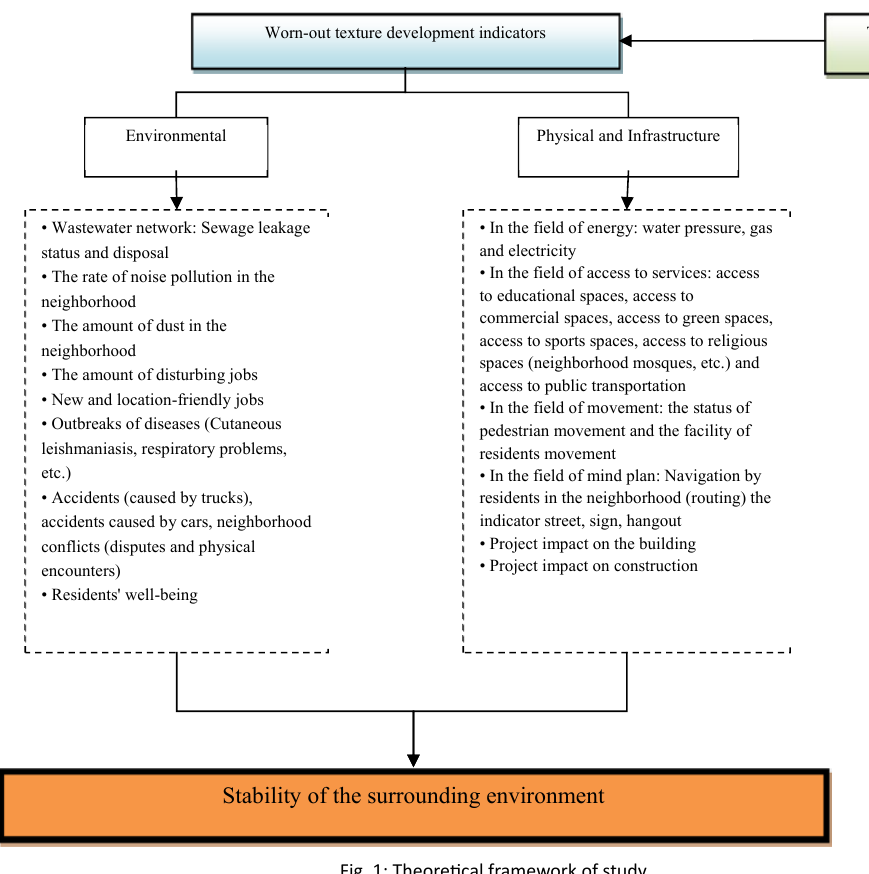
Worn-out texture development